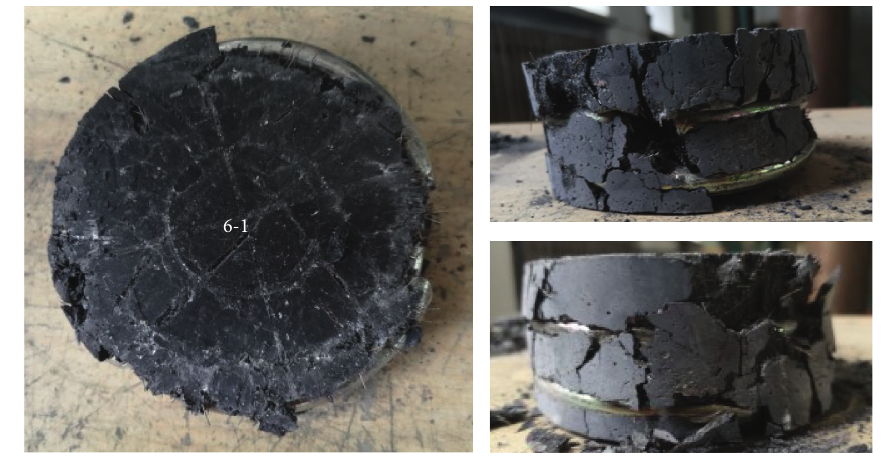
Figure 15: Failure mode of the sixth set of turntable